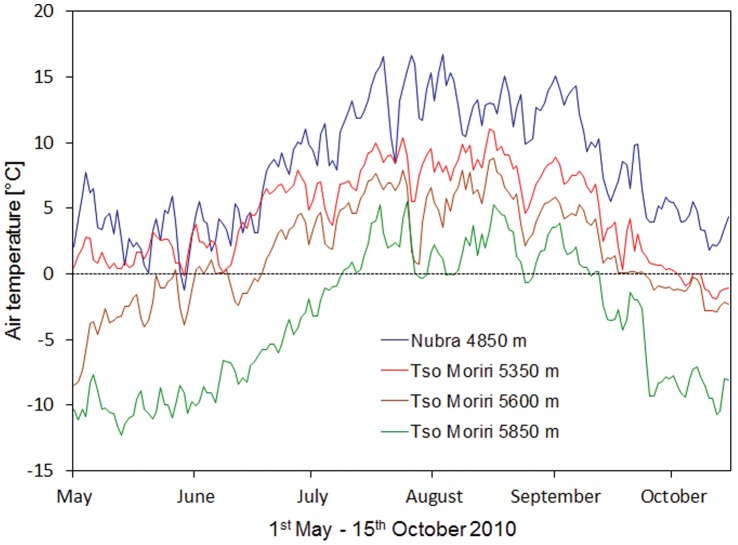
Changes in air temperature regime with increasing elevation.Shown are mean daily air temperatures during the summer season of 2010 for selected Nubra and Tso Moriri sites.